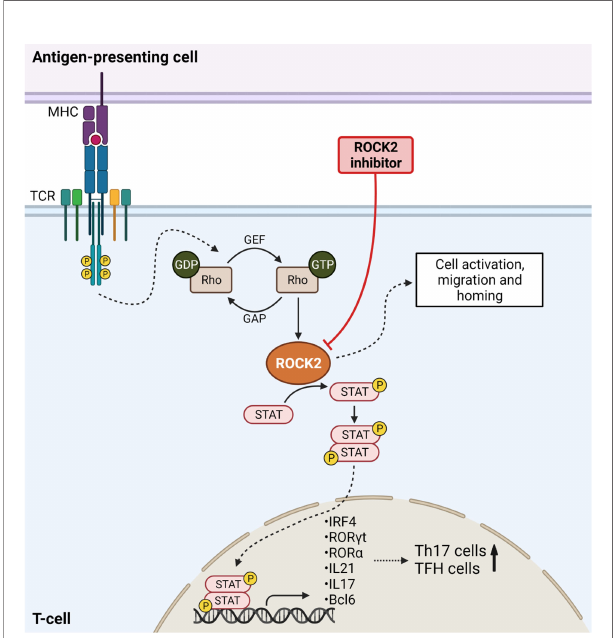
FIGURE 2 | ROCK2 mediates Th17 differentiation in Graft- versus -Host Disease. TCR stimulation results in downstream ROCK2 activation, thereby phosphorylating STAT molecules. STAT is translocated into the nucleus to activate the transcription of Th17-speci fi c transcription factors, thereby increasing the numbers of Th17 cells. ROCK2 activation further enhances the numbers of T follicular helper cells (TFH) and increases cell migration, activation and homing. Inhibition of ROCK2 blocks the differentiation of T-cells into TFH and Th17 cells and results in higher Treg numbers. Created with